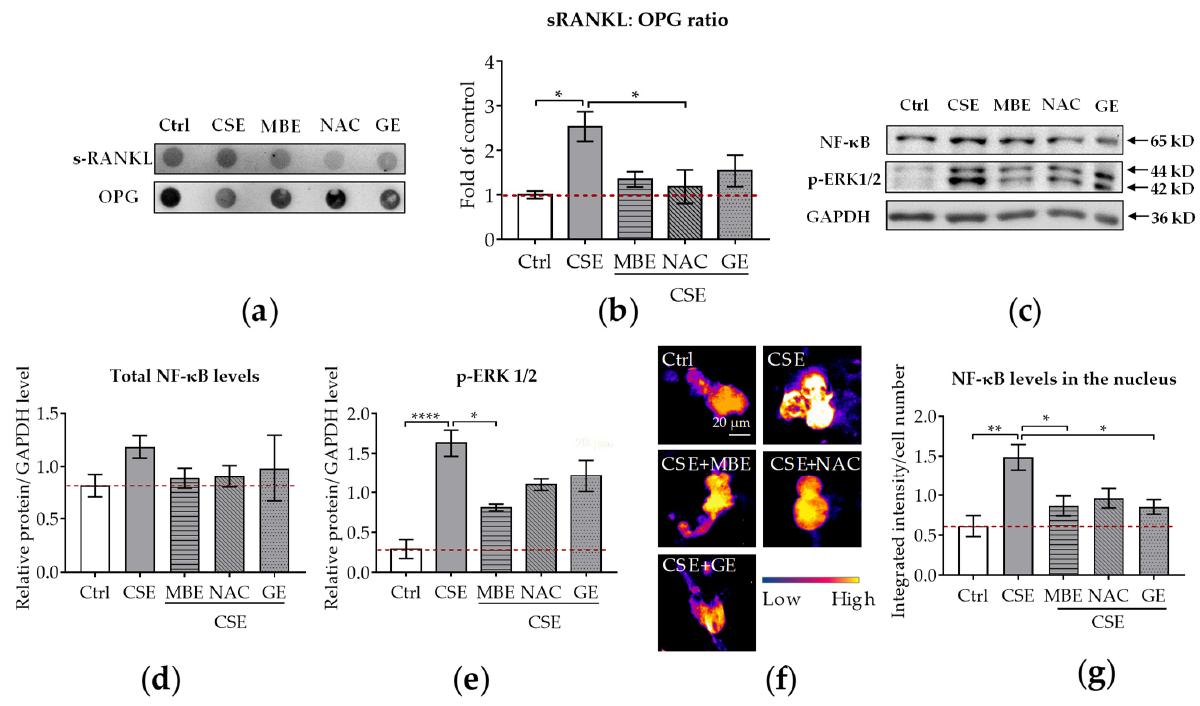
Figure 4. The sRANKL/OPG ratio and NF- κ B expression in the co-culture system. Dot blot was used to detect the secreted sRANKL and OPG levels in the co-culture system by day 14 ( N = 3, n = 3). Western blot ( N = 3, n = 2) and immunofluorescence staining ( N = 3, n = 3) were performed to detect the NF- κ B protein level in both thee co-culture system and nucleus on day 7. ( a ) A representative dot blot image showing the secreted protein levels of sRANKL and OPG in the supernatant. ( b ) The ratio of sRANKL and OPG in the co-culture system. ( c ) A representative Western blot image showing the total protein levels of NF- κ B and p-ERK1/2 in the co-culture system. ( d , e ) Quantitative analysis of total NF- κ B and p-ERK1/2 protein levels in the co-culture system. ( f ) A representative immunofluorescence image showing the protein expressions of NF- κ B (scale bar = 20 µm). ( g ) The NF- κ B protein level in the nucleus of the osteoclast. Statistical differences were determined using the Kruskal–Wallis test followed by Dunn’s multiple comparison test. Data are presented as means ± SEM, and the significance is shown as * p < 0.05, ** p < 0.01 and **** p < 0.0001 vs. CSE group.